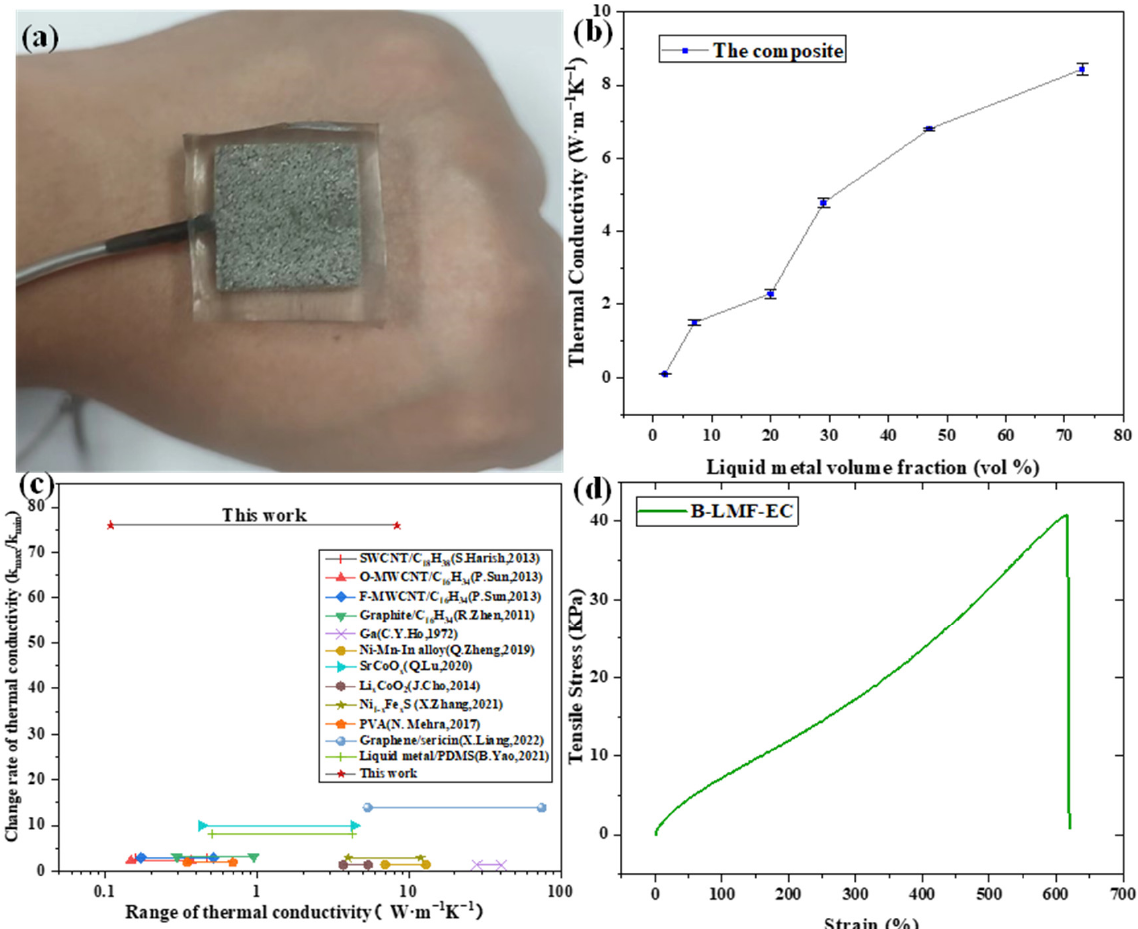
Figure 2. ( a ) Physical image of B-LM-ECF. ( b ) Variation curve of the adjustable thermal conductivity of B-LM-ECF with different liquid metal volume fraction. ( c ) Comparison of the performance of existing materials with adjustable thermal conductivity [39–49]. ( d ) Maximum tensile fracture curve of the B-LM-ECF.